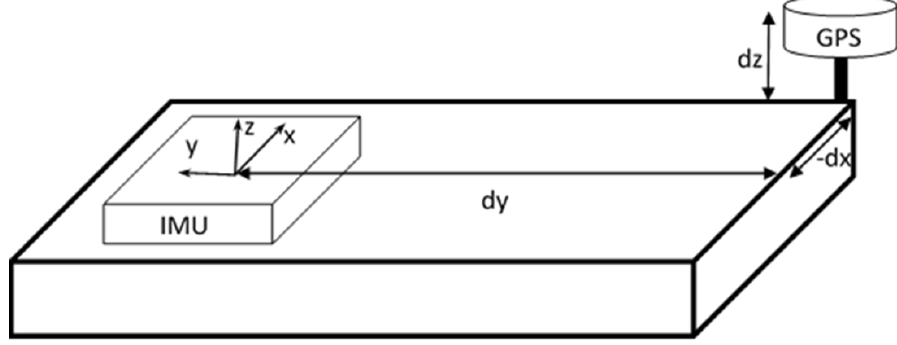
Figure 2. Boresight misalignment between the Inertial Measurement Unit (IMU) and GPS. 2. LiDAR (origin from which laser pulse is triggered) to the center of IMU 2. LiDAR (origin from which laser pulse is triggered) to the center of IMUThe origin and axes of the The origin and axes of the IMU are marked on the box. On the other hand, it is difficult to IMU are marked on the box. On the other hand, it is difficult to manually identify the axes of manually identify the axes of the laser scanner. Hence, the translation and rotation between the the laser scanner. Hence, the translation and rotation between the two origins are determined by two origins are determined by using a Terrestrial Laser Scanner (TLS). The TLS and the mobile using a Terrestrial Laser Scanner (TLS). The TLS and the mobile mapping unit are placed on a mapping unit are placed on a levelled plane. Both the mobile laser scanner and the TLS scans levelled plane. Both the mobile laser scanner and the TLS scans the vicinity. The mobile scanner the vicinity. The mobile scanner is fine scanned by the TLS such that the IMU markings are is fine scanned by the TLS such that the IMU markings are clearly visible on the point cloud. clearly visible on the point cloud. Points from the TLS point cloud belonging to the IMU center Points from the TLS point cloud belonging to the IMU center and IMU axes are picked. The origin and IMU axes are picked. The origin and axes of the TLS point cloud are shifted to the IMU and axes of the TLS point cloud are shifted to the IMU center and axes of the mobile mapping center and axes of the mobile mapping system. Since, the scale component is fixed, 3-D Helmert system. Since, the scale component is fixed, 3-D Helmert rigid body transformation is applied [35]. rigid body transformation is applied [35]. Now, the translation and rotation between the point Now, the translation and rotation between the point clouds from mobile laser scanner and TLS clouds from mobile laser scanner and TLS (centered at IMU) are measured using Iterative Closest Point (ICP) methodology introduced by [36,37]. One implementation of ICP as an open source software—CloudCompare [38] is used. The translation and rotation values determine the boresight misalignment between IMU and Laser Scanner. Laser